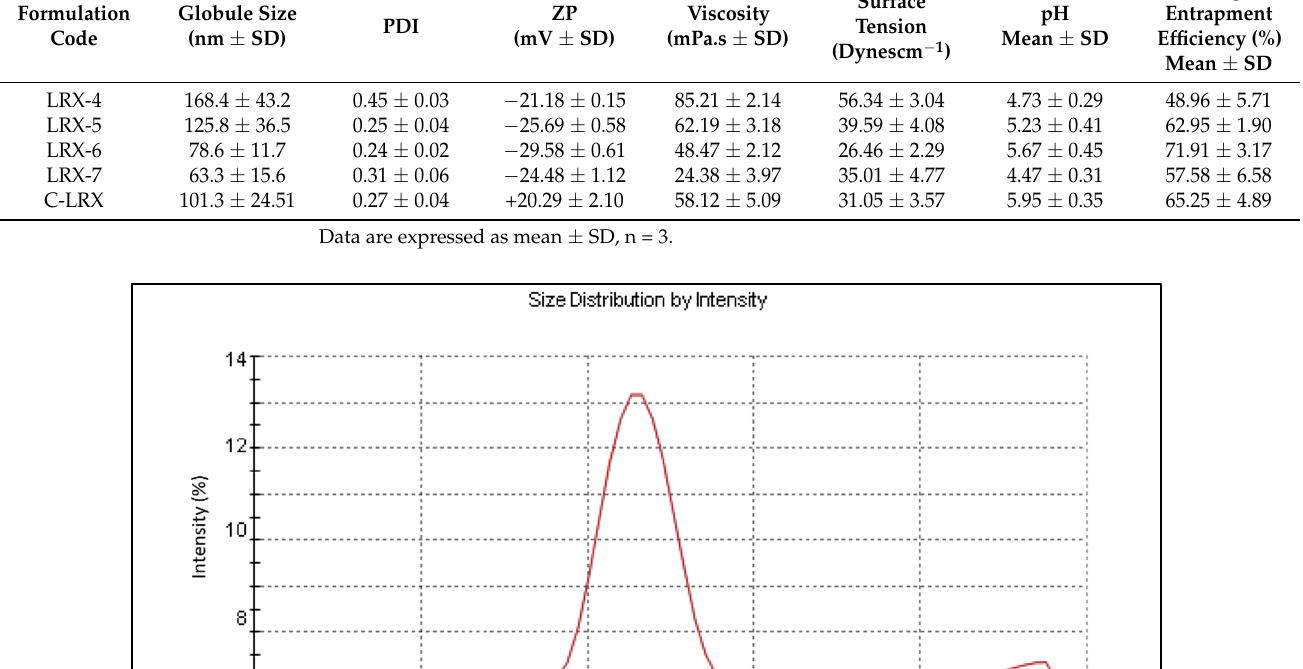
Figure 2. TEM images of ( A ) LRX-loaded NE ( B ) C-LRX-loaded NE.